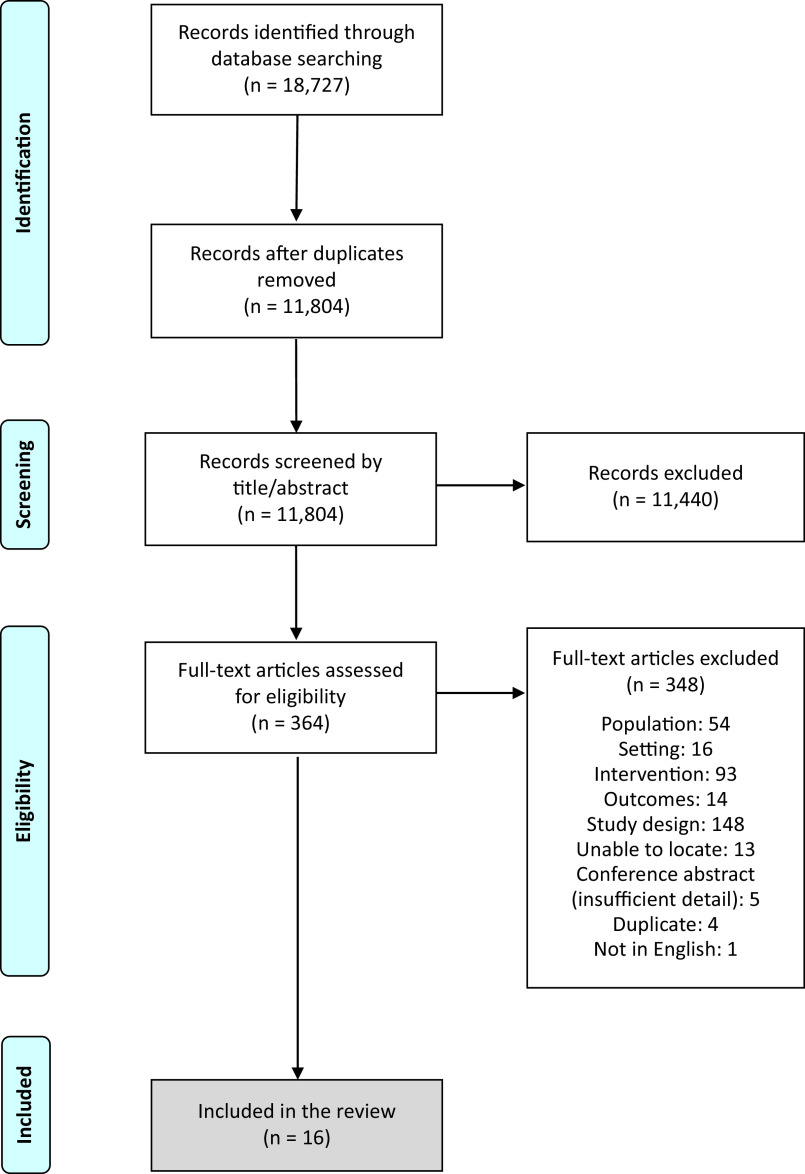
PRISMA flow diagram.